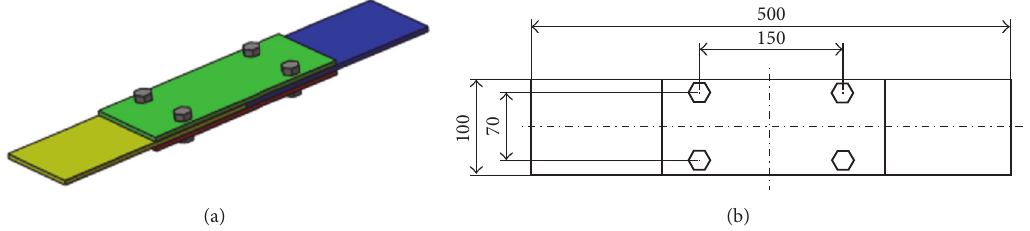
Figure 1: The double shear lap joint structure. Green: top plate; red: bottom plate; yellow and blue: middle plate.